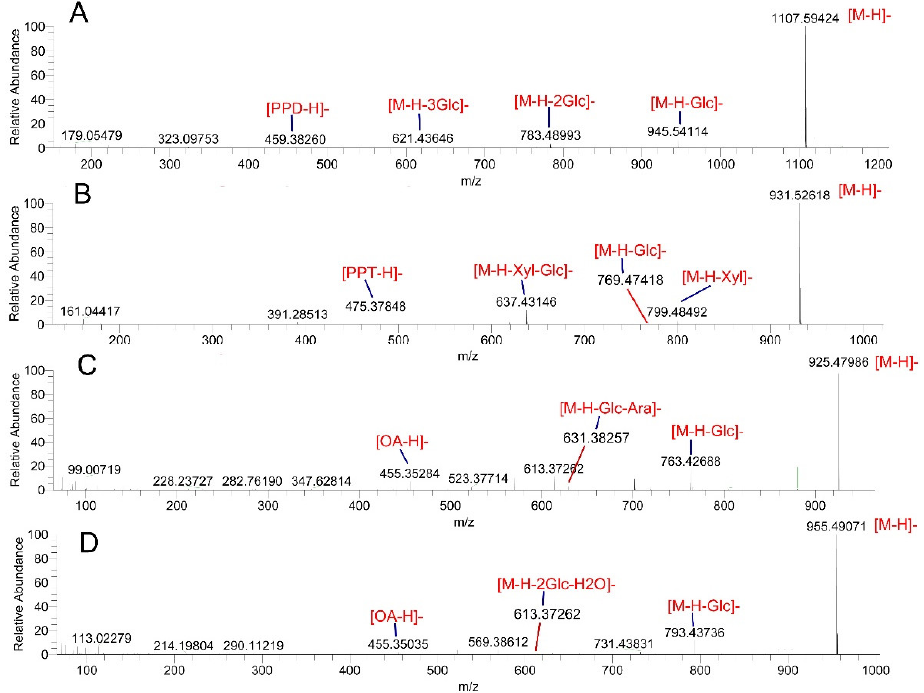
Figure 3. The MS/MS spectrum of ginsenoside -Rb1 ( A ), ginsenoside -R1 ( B ), ginsenoside -Ro ( C ), and chikusetsu saponin -IV ( D